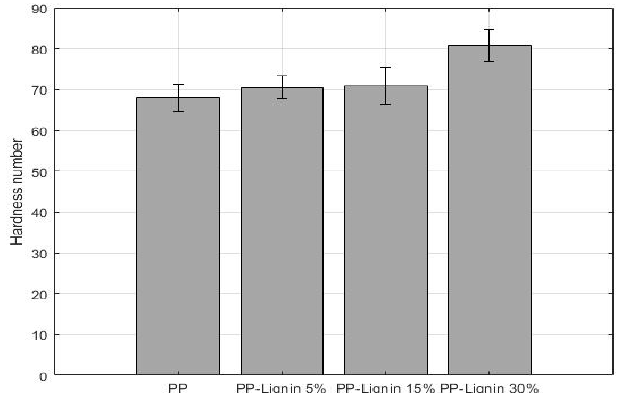
Figure 8 . Shore D hardness values of lignin blends . Figure 8. Shore D hardness values of lignin blends.